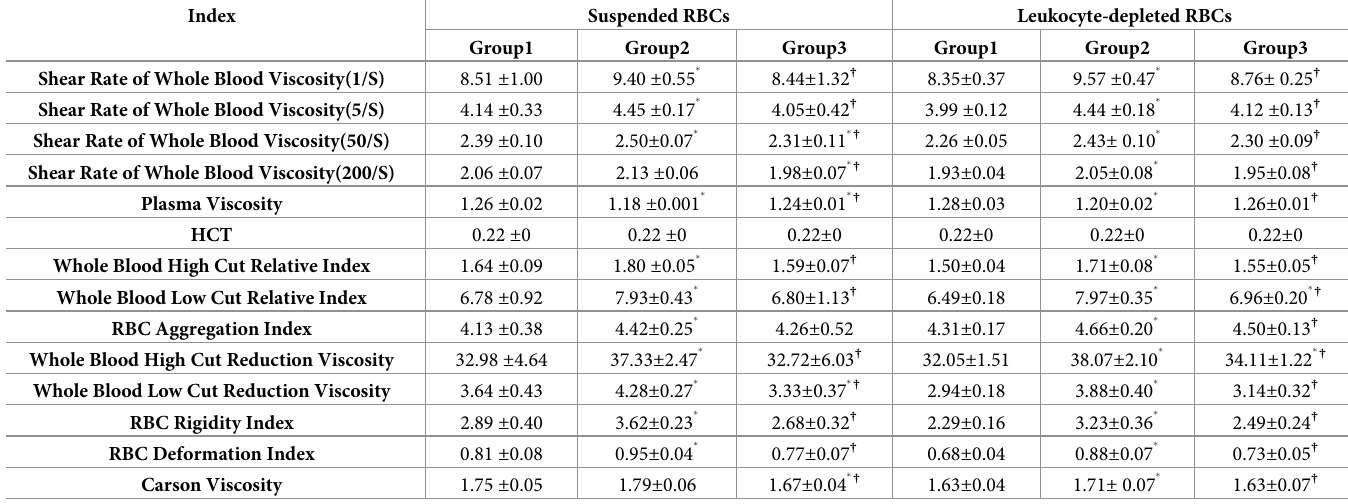
Table 2. The hemorheologic indexes over 14 days of